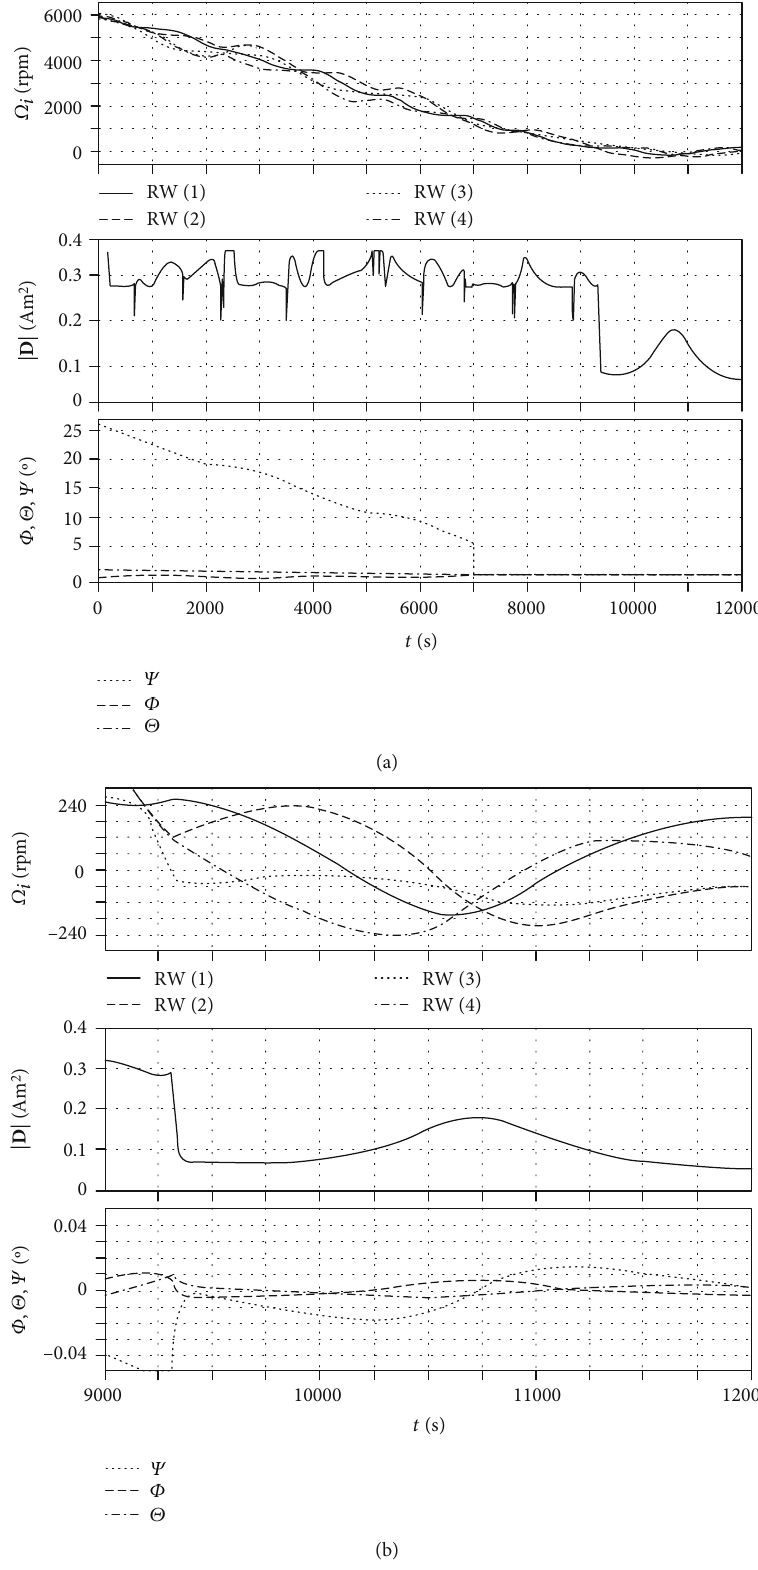
Figure 12: (a) Momentum unloading mode, reaction wheels in pyramid con fi guration. (b)